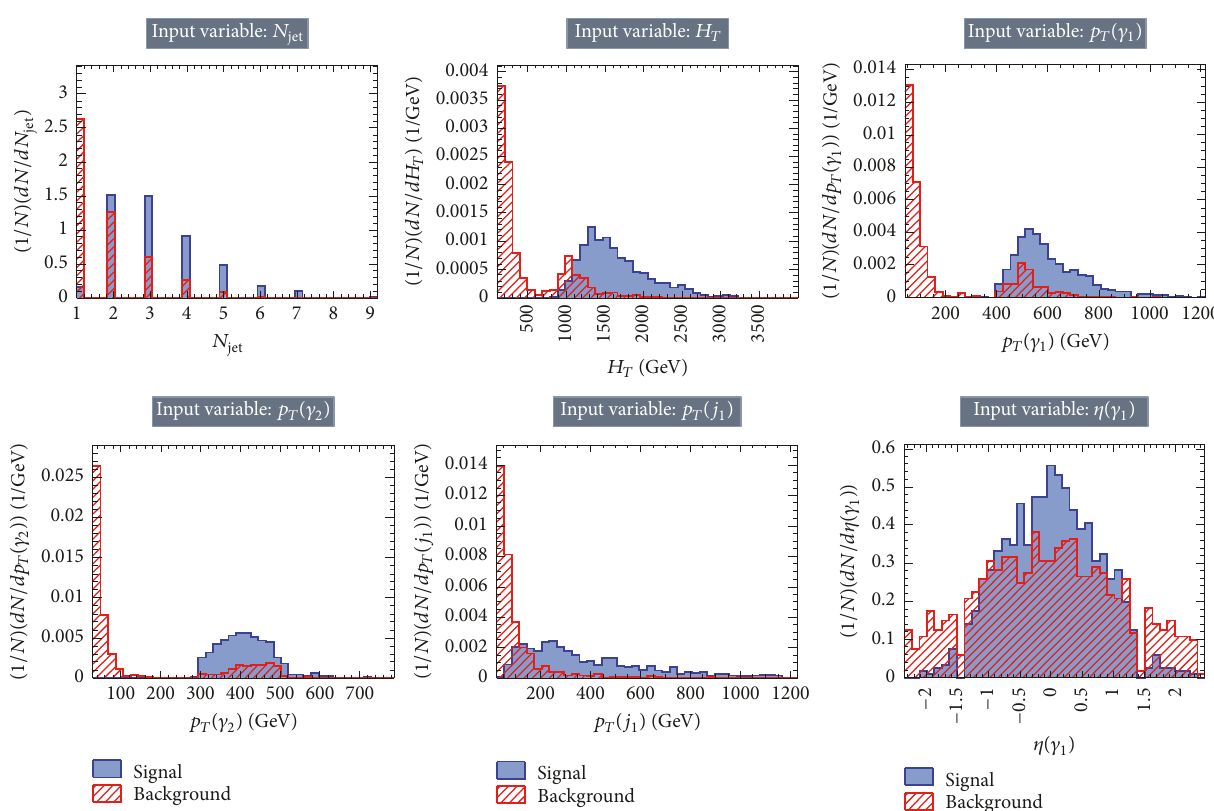
Figure 9: Normalized distributions of a few sample input variables for the signal ( 𝑊𝑊 fusion with 𝑀 Φ = 1 TeV) and background at the LHC ( √𝑠 = 13 TeV). These distributions are obtained by applying the selection cuts defined in Section 3.3.